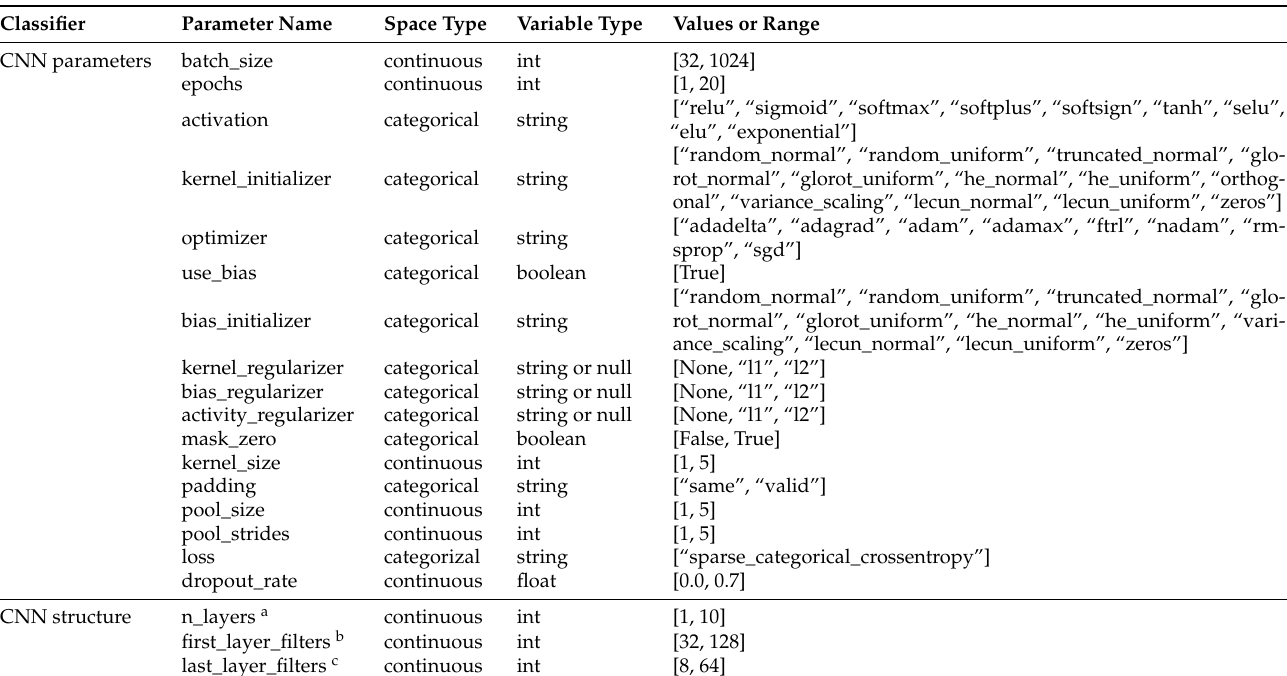
Table A3. Parameters and their values and ranges considered for EO hyperparameter search: the case of